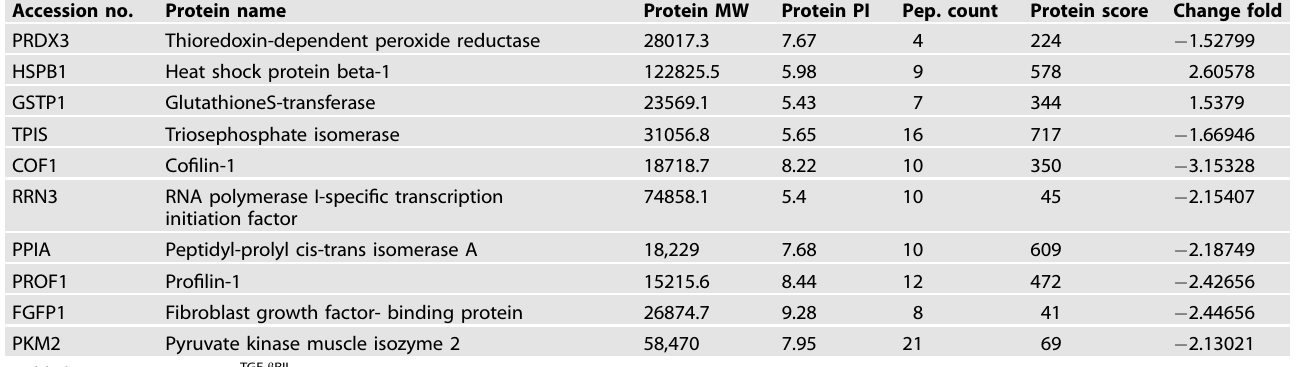
Fold change (CAFs vs. CAFs TGF- β RII